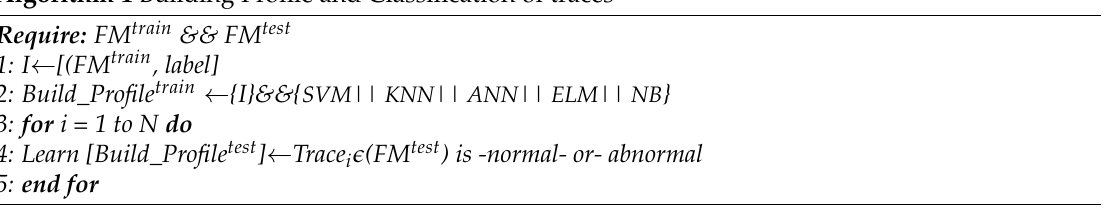
Algorithm 1 Building Profile and Classification of traces